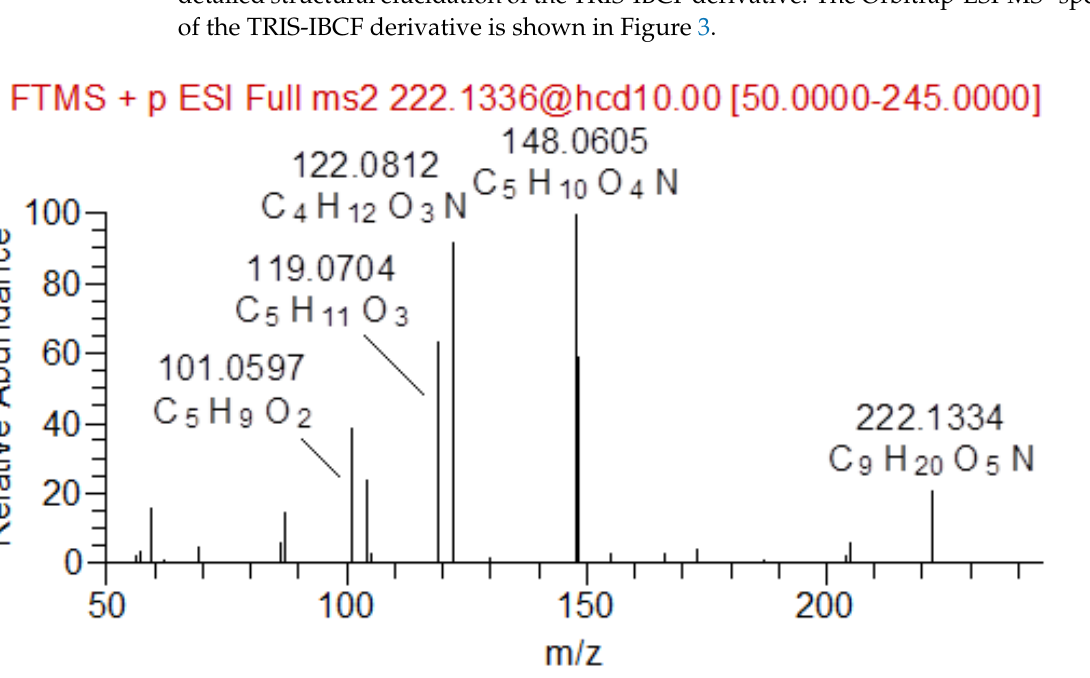
Figure 2. The chromatographic peak shape of TRIS before ( a ) and after derivatization ( b ) with IBCF at 10 ng/mL.